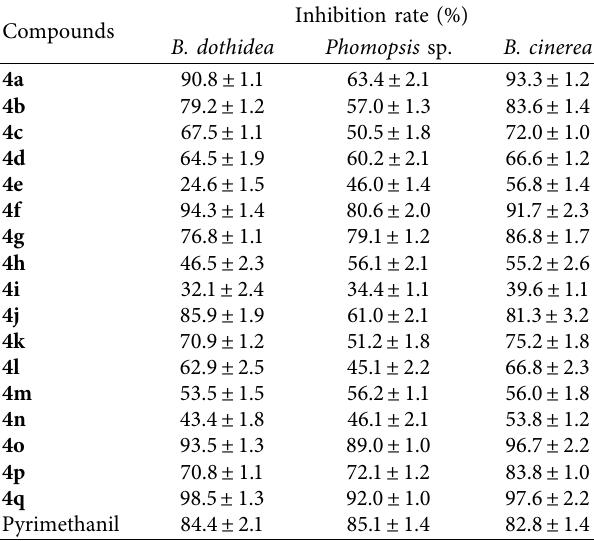
Table 1: The in vitro antifungal activities against Phomopsis sp., B. dothidea , and B. cinerea of the target compounds 4a – 4q at 50 µ